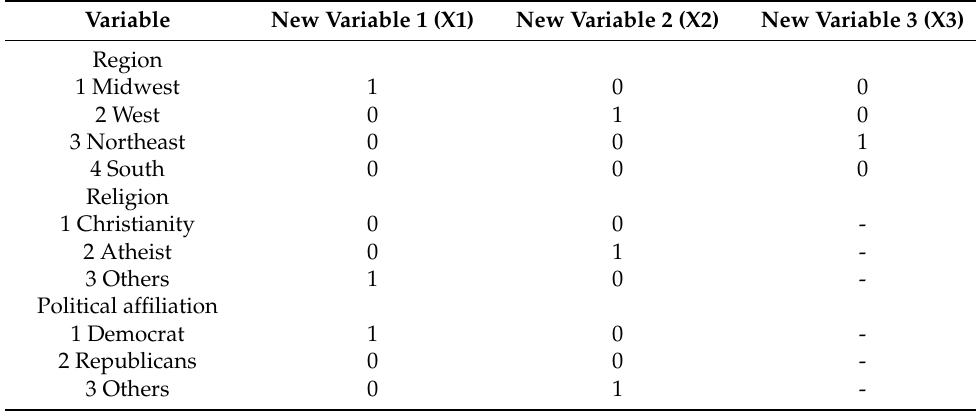
Table A1. Dummy coding algorithm of polytomous variables used in the